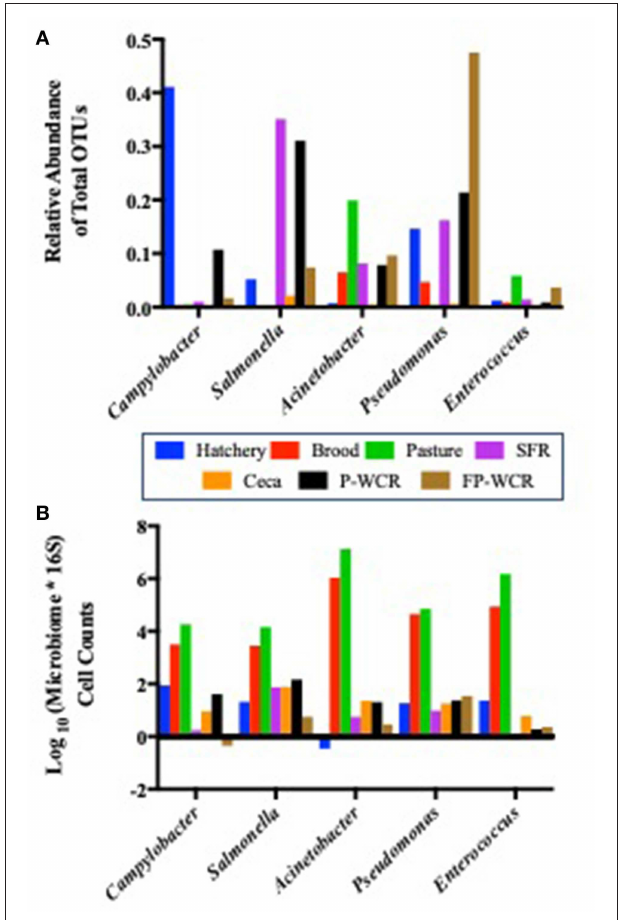
FIGURE 6 | Prevalence of five core zoonotic taxa within the total microbiomes from different sample types and stages along the farm-to-fork continuum of a pasture-raised broiler flock. (A) Relative abundances of the five core zoonotic taxa within the total microbiomes (430 total taxa). (B) Log 10 -transformed quantified microbiome cell counts of the five core zoonotic taxa, based on multiplying the microbiome relative abundance data by the total bacterial counts for each sample according to 16S qPCR